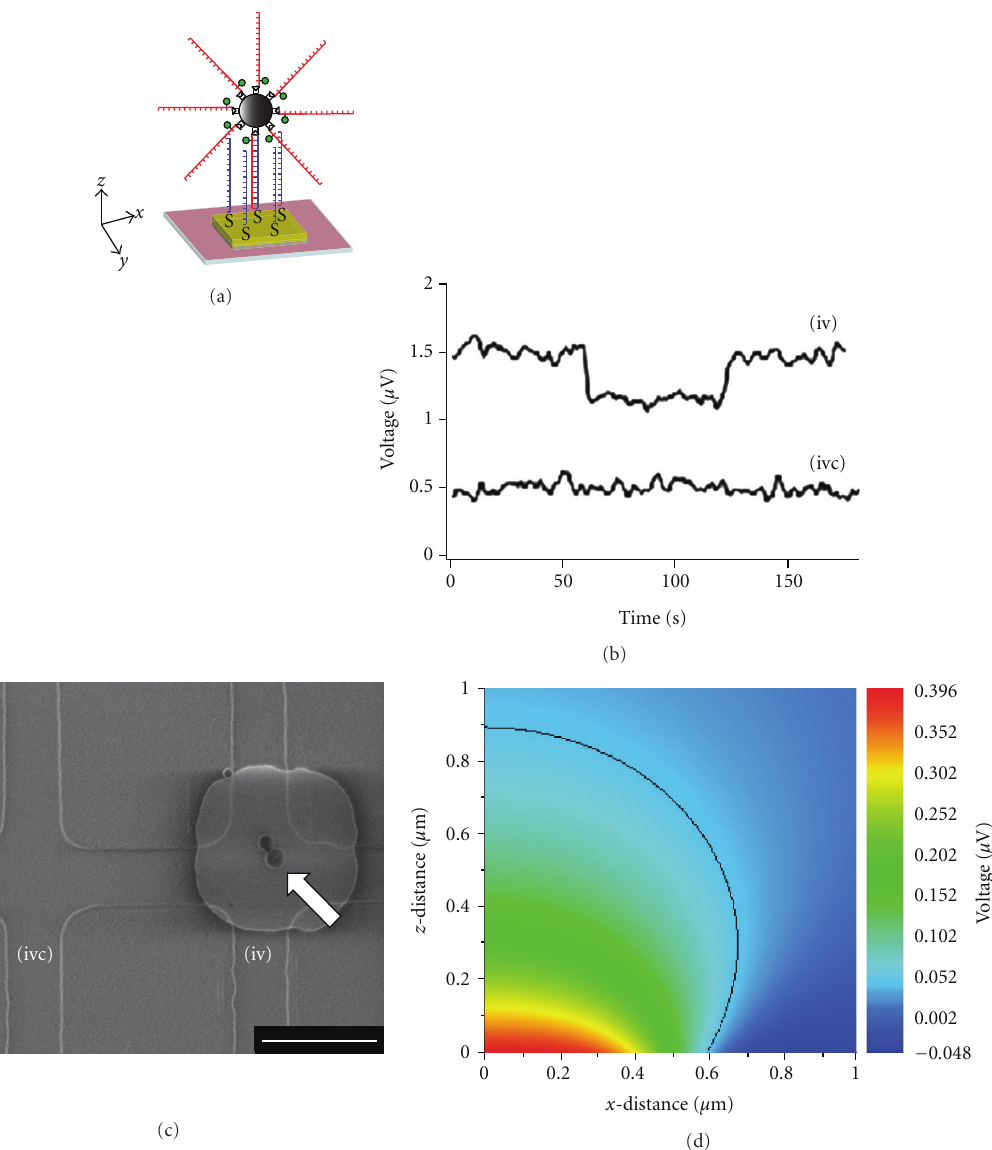
Figure 3: Sequence-specific two-strand DNA assembly and subsequent Hall detection of a single 344 nm nanobead. (a) Pictorial representation of two-strand DNA assembly, where the probe DNA (red) is complementary to the receptor DNA (blue). (b) Hall response data for the active (iv) and control Hall junction (ivc) plotted as Hall voltage versus time, where the drop in Hall voltage corresponds to the presence of a magnetic nanobead. (c) SEM was used to confirm that only one nanobead contributed significantly to the signal measured in (iv); scale bar = 2 µ m. (d) The theoretical Hall device cross-sectional response for a single 344 nm SPM bead as a function of position from the center of the junction, where red indicates strongest change in voltage, aqua indicates weakest voltage change, and blue indicates a negative voltage readout. The noise floor for the device is outlined in black for